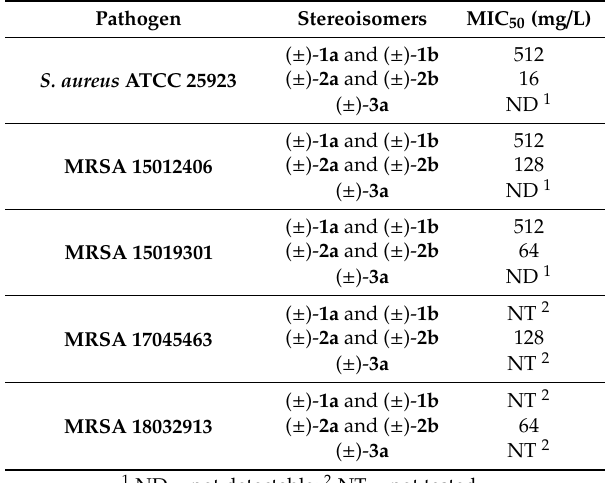
and MRSA strains.